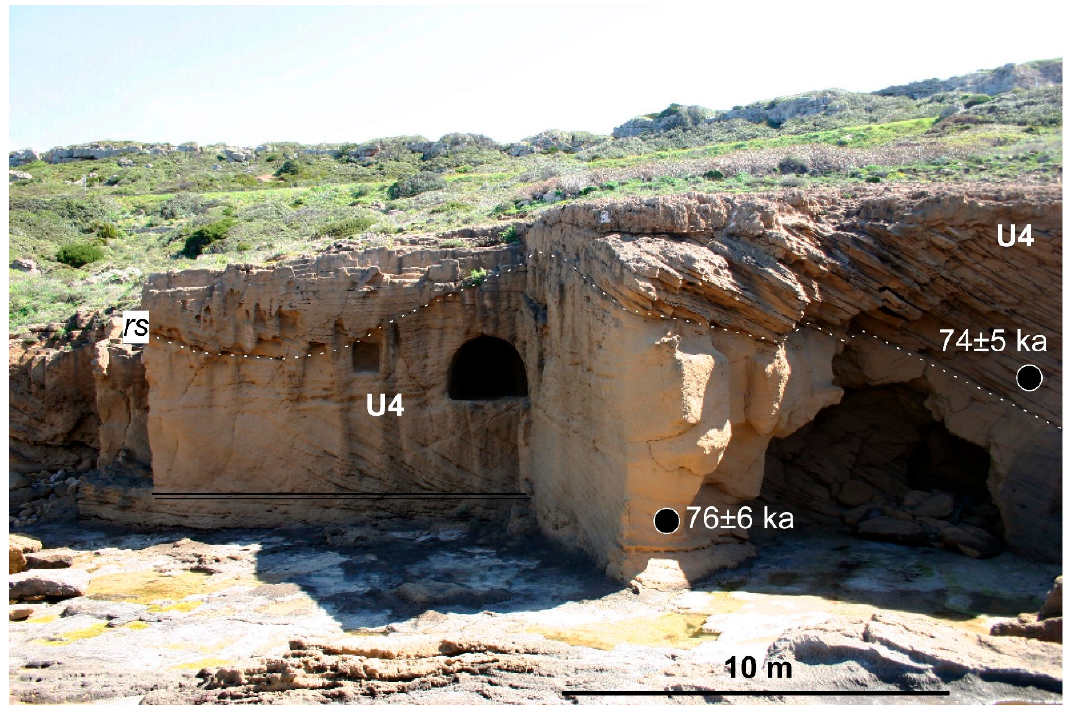
Figure 9. The sandstone Unit 4 deposits at the Zio Peppino quarry. Luminescence ages are made of Figure9. ThesandstoneUnit4depositsattheZioPeppinoquarry. Luminescenceagesaremadeofquartz quartz grains (OSL [32]). rs = reactivation surface separating sandstones with different cementation grains (OSL [32]). rs = reactivation surface separating sandstones with di ff erent cementation degree. Geosciences 2019 , 9 , x FOR PEER REVIEW degree.